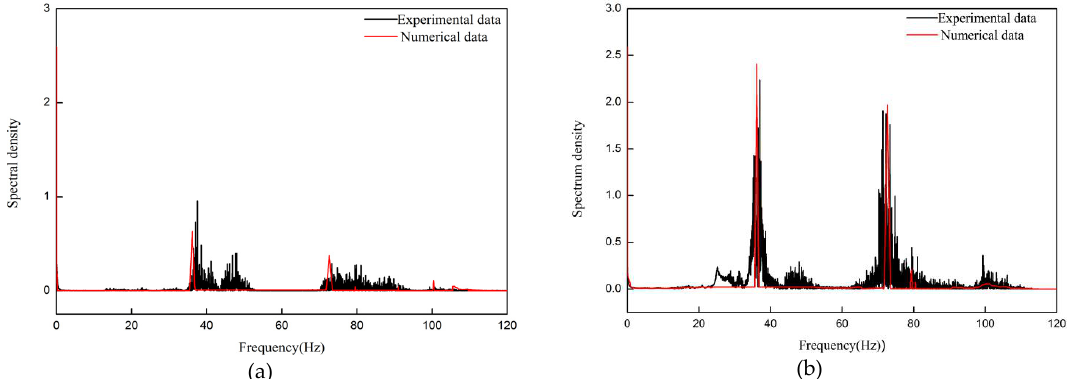
Figure 6. Pressure in frequency domain with FSI taking into account ( a ) closer outlet; ( b ) near surge chamber. The red solid line refers to numerical result, the black solid line refers to experimental result.